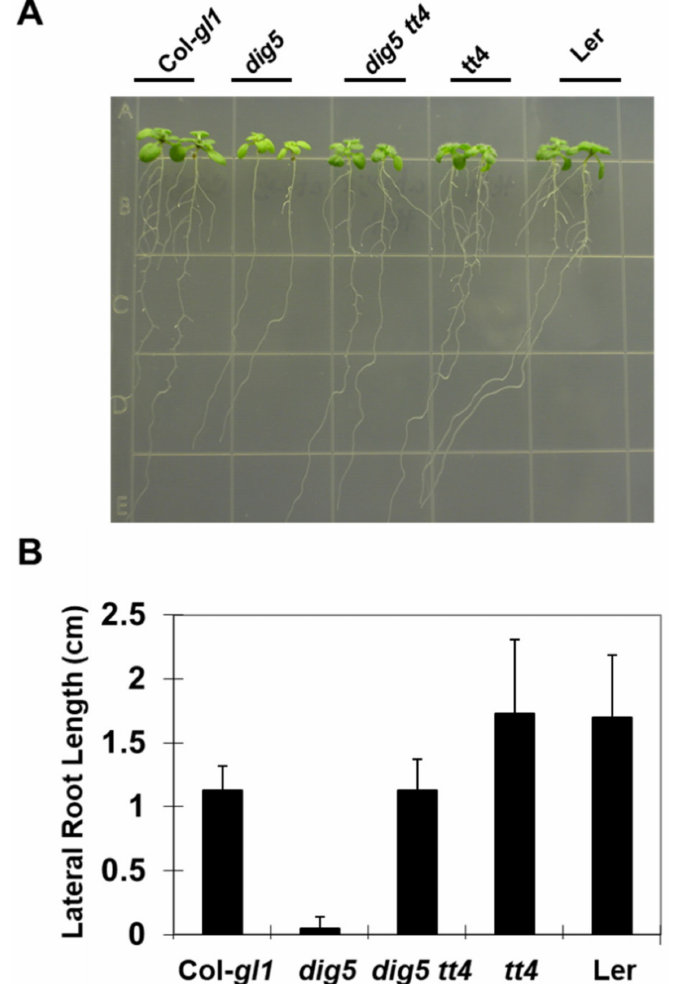
Figure 10. Loss-of-function mutation of TT4 rescued the development defects in lateral roots of dig5 mutant seedlings. The dig5 tt4 double mutant was generated by genetic crossing. ( A ) Morphology of 2-week-old seedlings grown on 1/2 MS medium. ( B ) Total lateral root length per plants. Data are means and standard deviation from 6